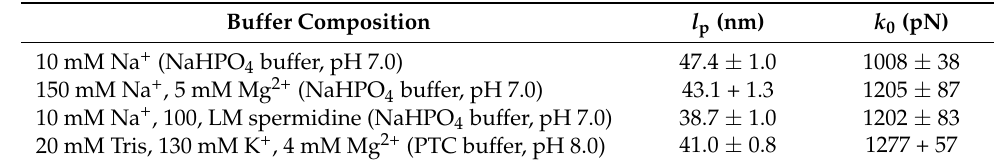
Figure 7. Stretching of a single DNA molecule with OT. The two ends of the molecule (black line) are attached to two colloidal spherical particles; one is fixed by a micropipette tips (cyan truncated triangle) and the other one is confined within an optical potential (red curve). ( a ) When the extension of the DNA molecule is shorter than 𝑙 0 , i.e., (𝑥 2 − 𝑥 1 ) < 𝑙 0 , a very small force is need to extend the polymer chain by pulling the trapped particle and eliminating the bends; the trapped particle re- mains almost centered at its equilibrium position, 𝑥 eq . Where 𝑥 1 and 𝑥 2 are the positions of the two ends of the DNA molecule, 𝑥 1 is fixed, while 𝑥 2 changes according to the position of the trapped particle. ( b ) When (𝑥 2 − 𝑥 1 ) → 𝑙 0 , the DNA molecule shows an elastic stiffness, 𝑘 0 , and the stretching force increases with the stretching. In this case, the trapped bead is displaced by ∆𝑥 eq = (𝑥 − 𝑥 eq ) from its equilibrium position. The position 𝑥 1 is experimentally set and fixed at the be- ginning of an experiment; 𝑥 2 can be easily calculated from the particle position 𝑥 knowing the size of the bead; 𝑥 eq and the stretching force can be obtained by OT calibration. ( c ) Direct tapping of an RBC without any attached bead before (top) and during stretching (bottom). A two-beam OT is used to trap the two extremities of an RBC; one trap is fixed, while the other one is moved to stretch the cell; red spots indicate the position of focused laser beams. ( d ) Sketch of a macrophage internaliza- tion of a vaterite microspheres; the red spot indicates the laser beam, and the curved arrow indicates the direction of the particle rotation. Table 4. DNA elasticity parameters for different multivalent cation buffer solutions. Reprinted/ adapted with permission from Ref. [181]. Copyright 1997, Elsevier.